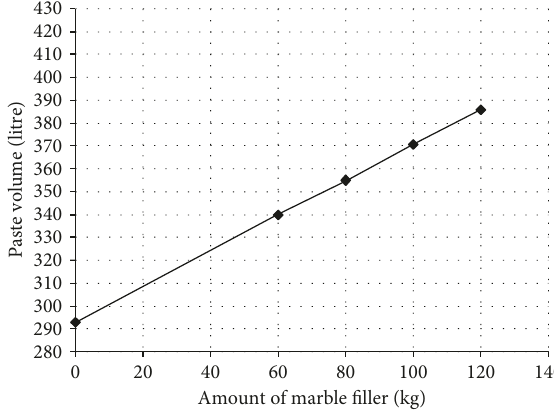
Figure 2: Volume of the paste according to the amount of MP.